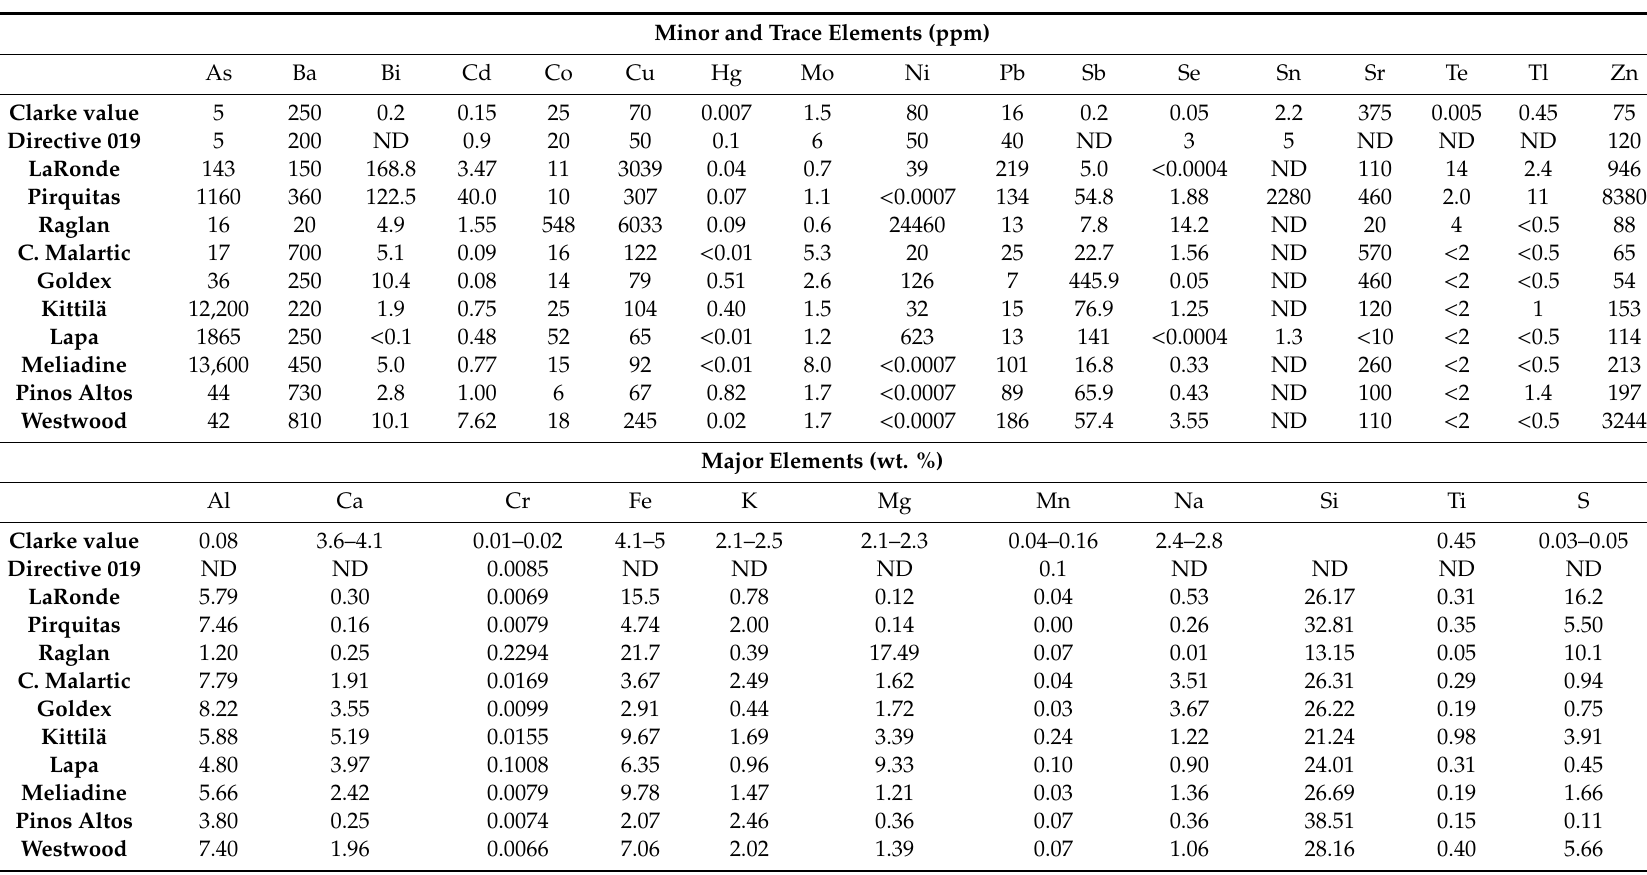
Table A3. Major, minor and trace elements of the ores’ sample. For minor and trace elements, and for Cr, Mn, and S, the values above the Directive 019 values are in light gray, the values above ten times the Clarke values or above both the defined thresholds are in dark gray; ND: No